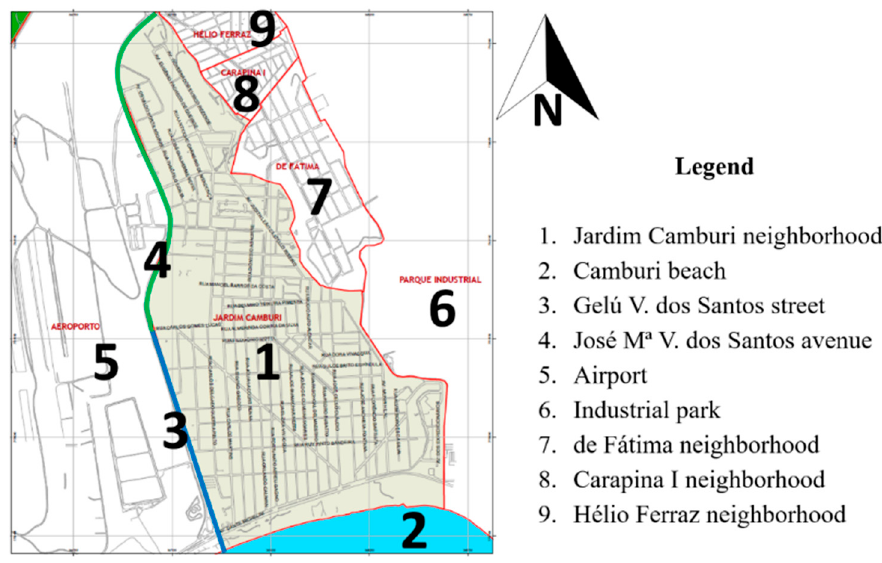
Figure 1. Detailed map of Jardim Camburi, Vitória Espírito Santo (ES), and the boundaries of the neighborhood.